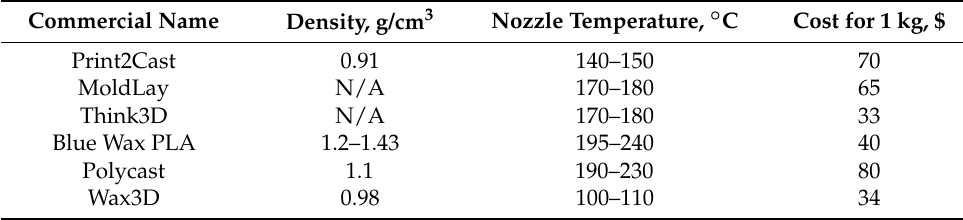
Table 2. Commercially available castable FDM